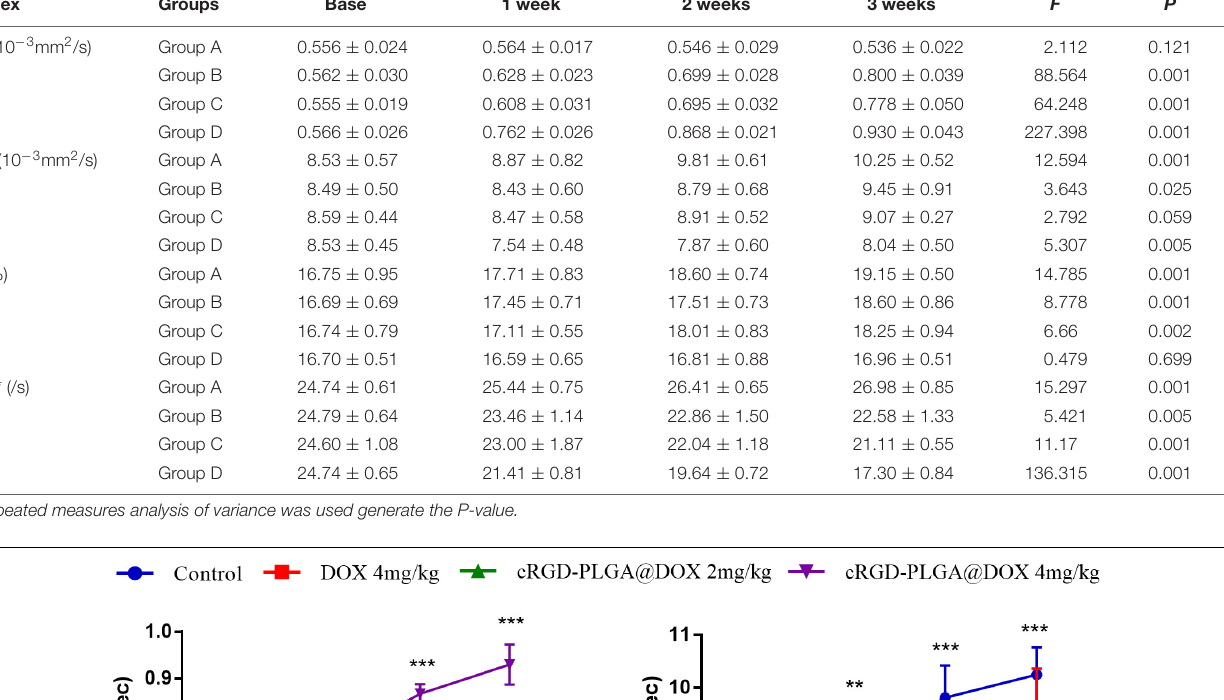
TABLE 2 | The quantitative MRI parameters at different time points from the four groups.